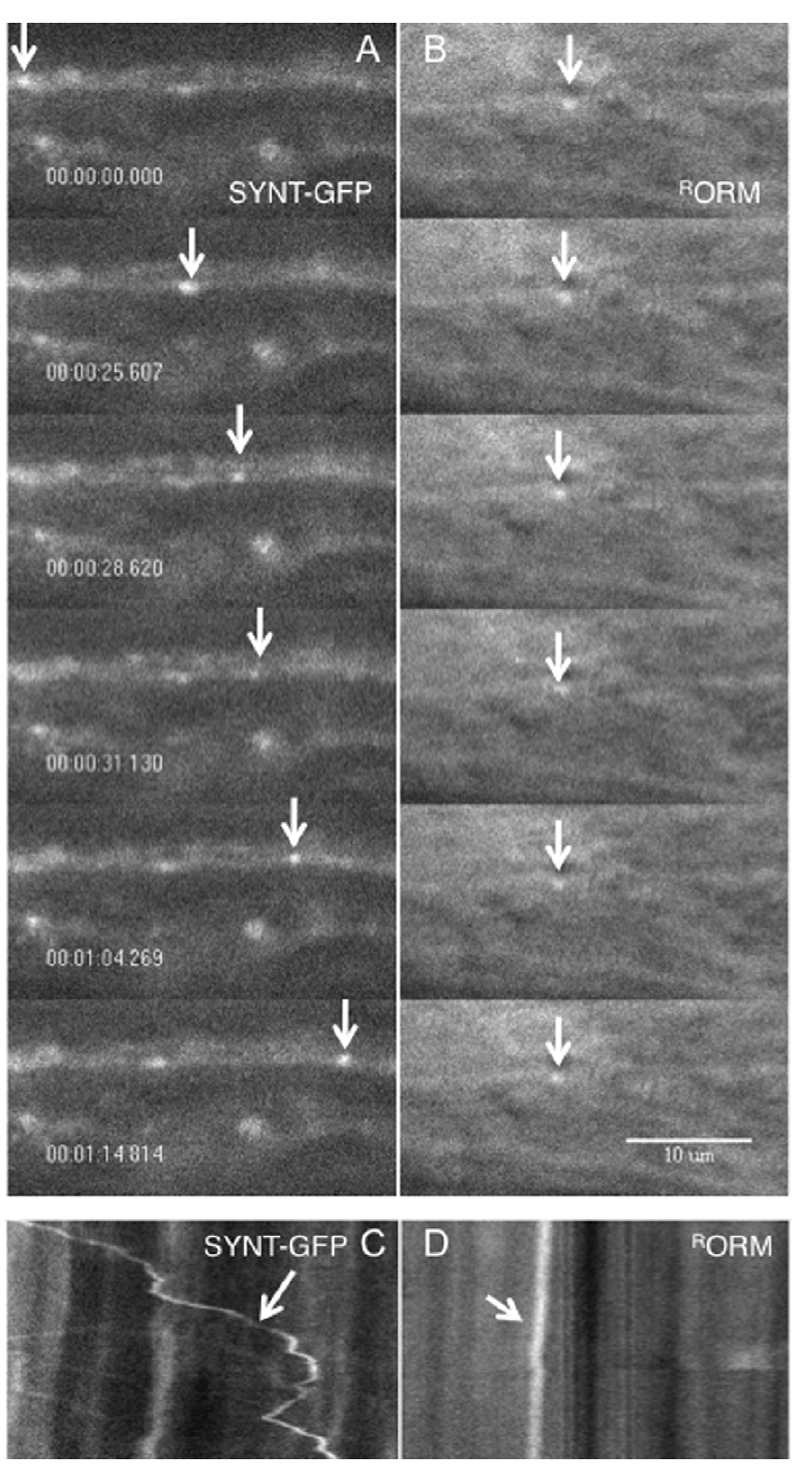
Figure 8. ORMOSIL incorporation does not affect the movement of synaptotagmin vesicles. (A, B) In vivo imaging suggests that ORMOSIL incorporation does not affect the movement of GFP-tagged synaptotagmin vesicles within living dissected ORMOSIL treated larvae. Single frames from a representative movie containing both GFP-tagged synaptotagmin vesicles (SYNT-GFP, A) and R ORM (B) simultaneously imaged show the movement of SYNT-GFP vesicles within a larval segmental nerve incubated with ORMOSIL. Note that the SYNT vesicle shows movement in each frame (arrow). ( B ) Note that ORMOSIL is also observed within the same larval segmental nerve (arrow). Note that ORMOSIL does not dramatically change in each frame (arrow). A 1 min movie is depicted. Movies were taken using the 100 6 objective. Bar=10 m m. (C,D) Kymographs show that ORMOSIL treatment does not affect the movement of GFP-tagged synaptotagmin vesicles. Kymographs from the above movies show that the movement dynamics of SYNT-GFP vesicles are not affected in R ORM treated larvae. The movement of a SYNT-GFP vesicle is seen moving from the left to the right (arrow, C), while a slight shift is seen for ORMOSIL (arrow, D).